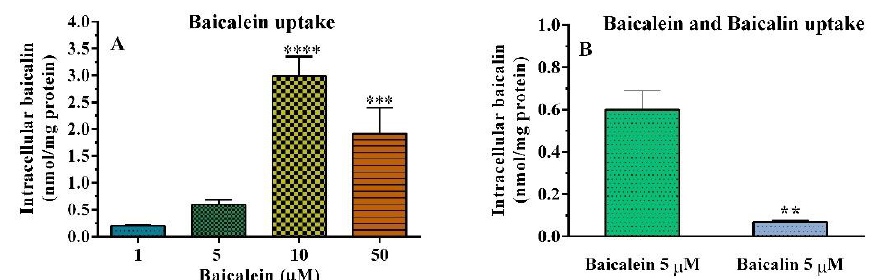
Figure 10. Intracellular baicalin content measured in HT–29 cells after 3 h of incubation with baicalein (1–50 µ M, ( A )), and baicalein and baicalin at 5 µ M ( B ). Each value represents the mean ± SEM of at least 3 experiments. ** p < 0.01, *** p < 0.001 and **** p < 0.0001 versus intracellular baicalin content detected using baicalein 1 µ M ( A ) or baicalein 5 µ M ( B ).